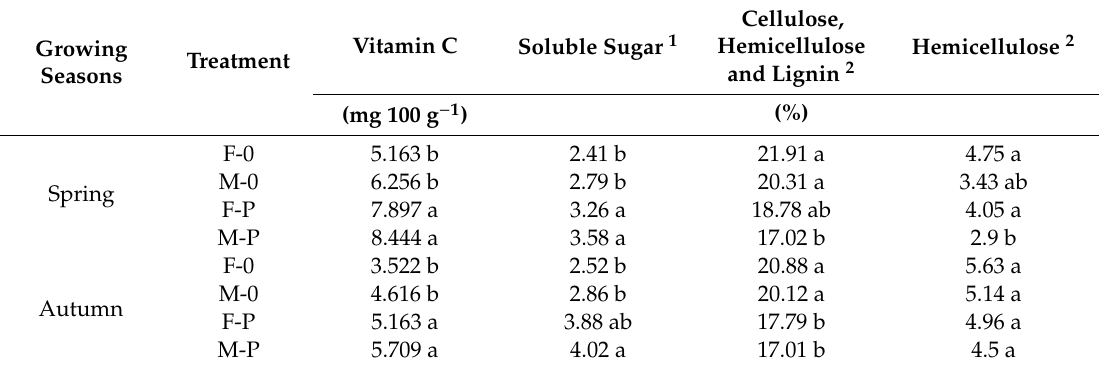
Table 3. The Vitamin C, soluble sugar and cellulose, hemicellulose, and lignin contents in pakchoi under di ff erent water management techniques in spring and autumn seasons.